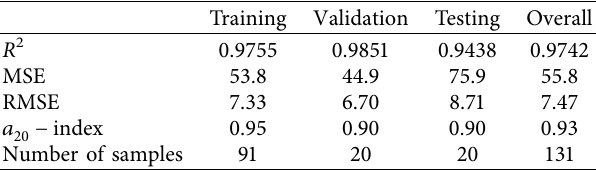
Table 6: Performance results of the ANN